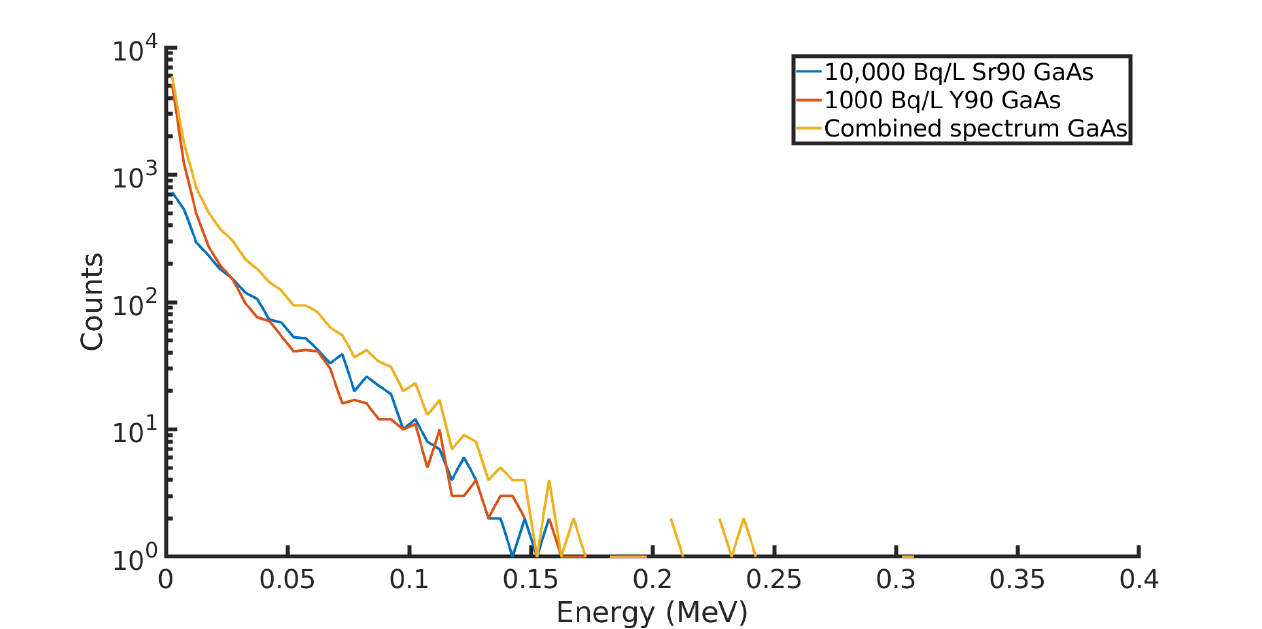
Figure 4. 90 Sr and 90 Y counts recorded in a GaAs detector in a groundwater borehole simulation. The combined spectrum is plotted in